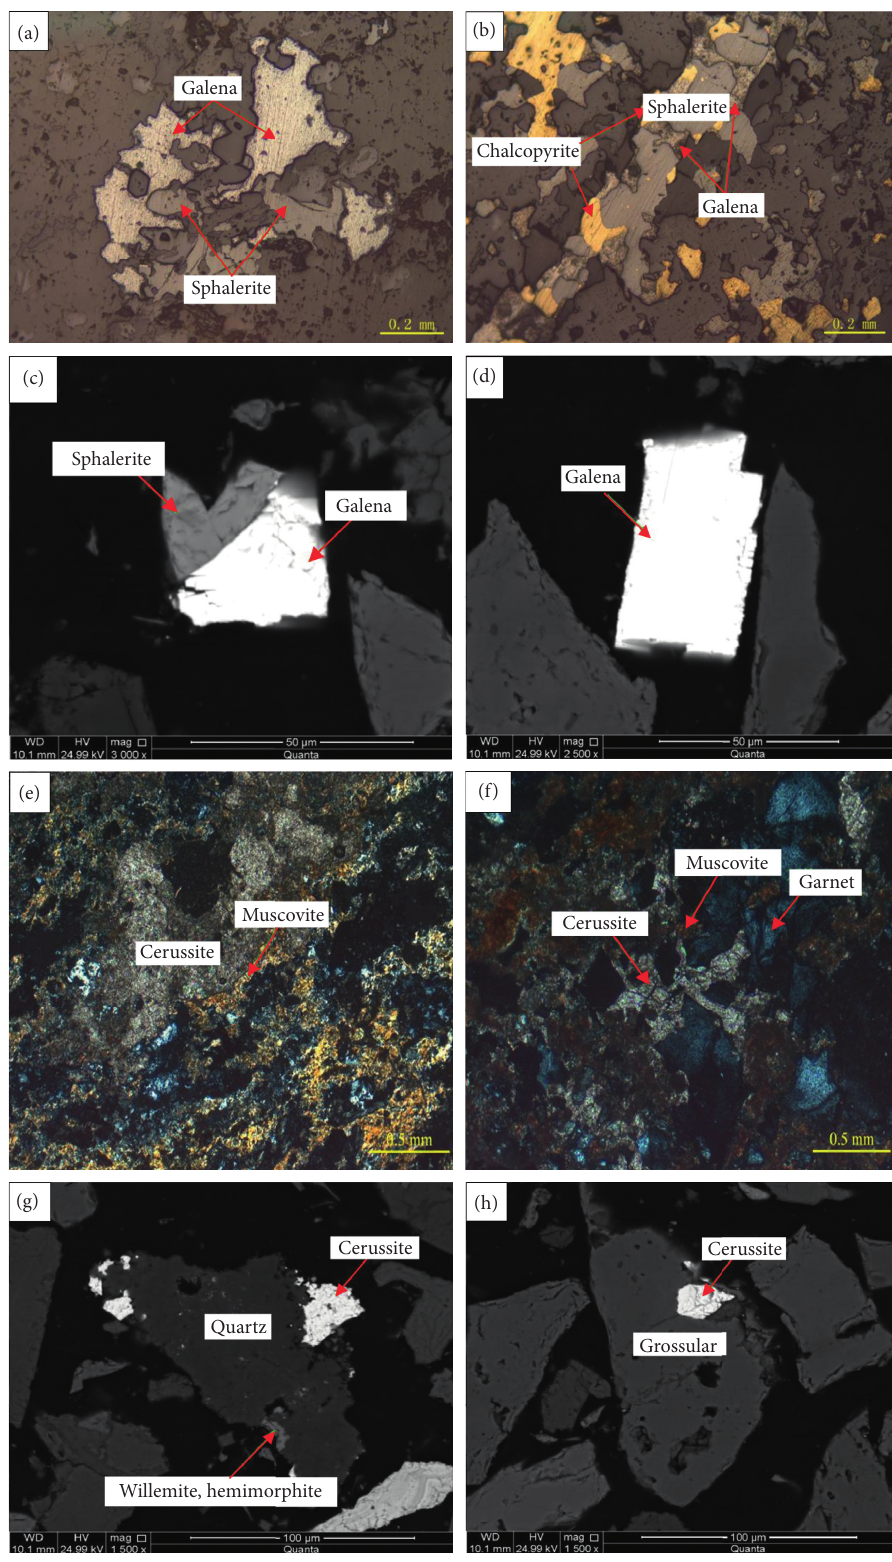
Figure 8: Embedded characteristics of galena and